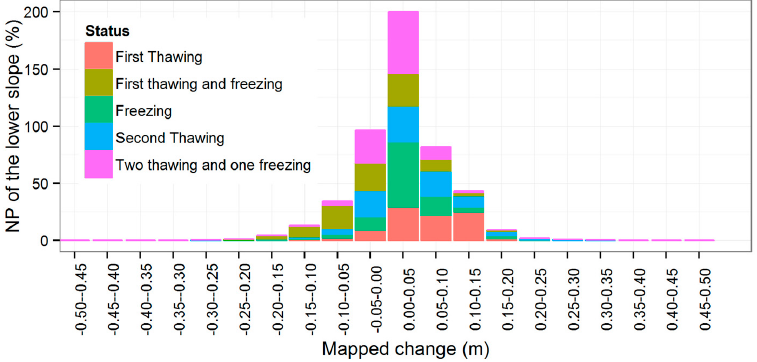
Figure 9. Normalized breakdown of the lower slope change mapped during the freeze–thaw cycles. NP denotes the normalized percentage.